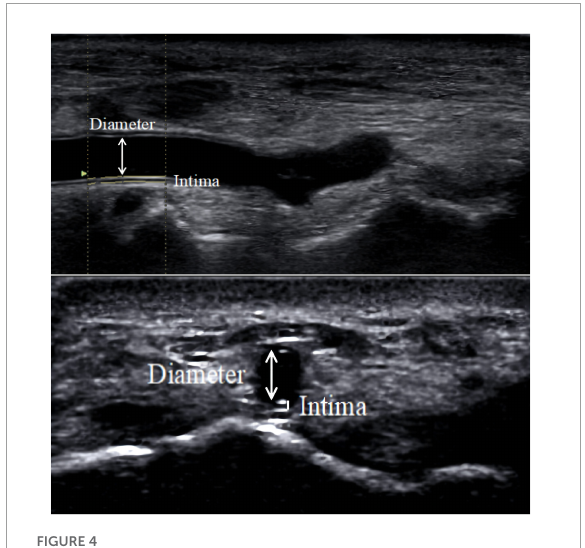
FIGURE4 DRA diameter. The diameter measured in the figure is the distance from the media to the